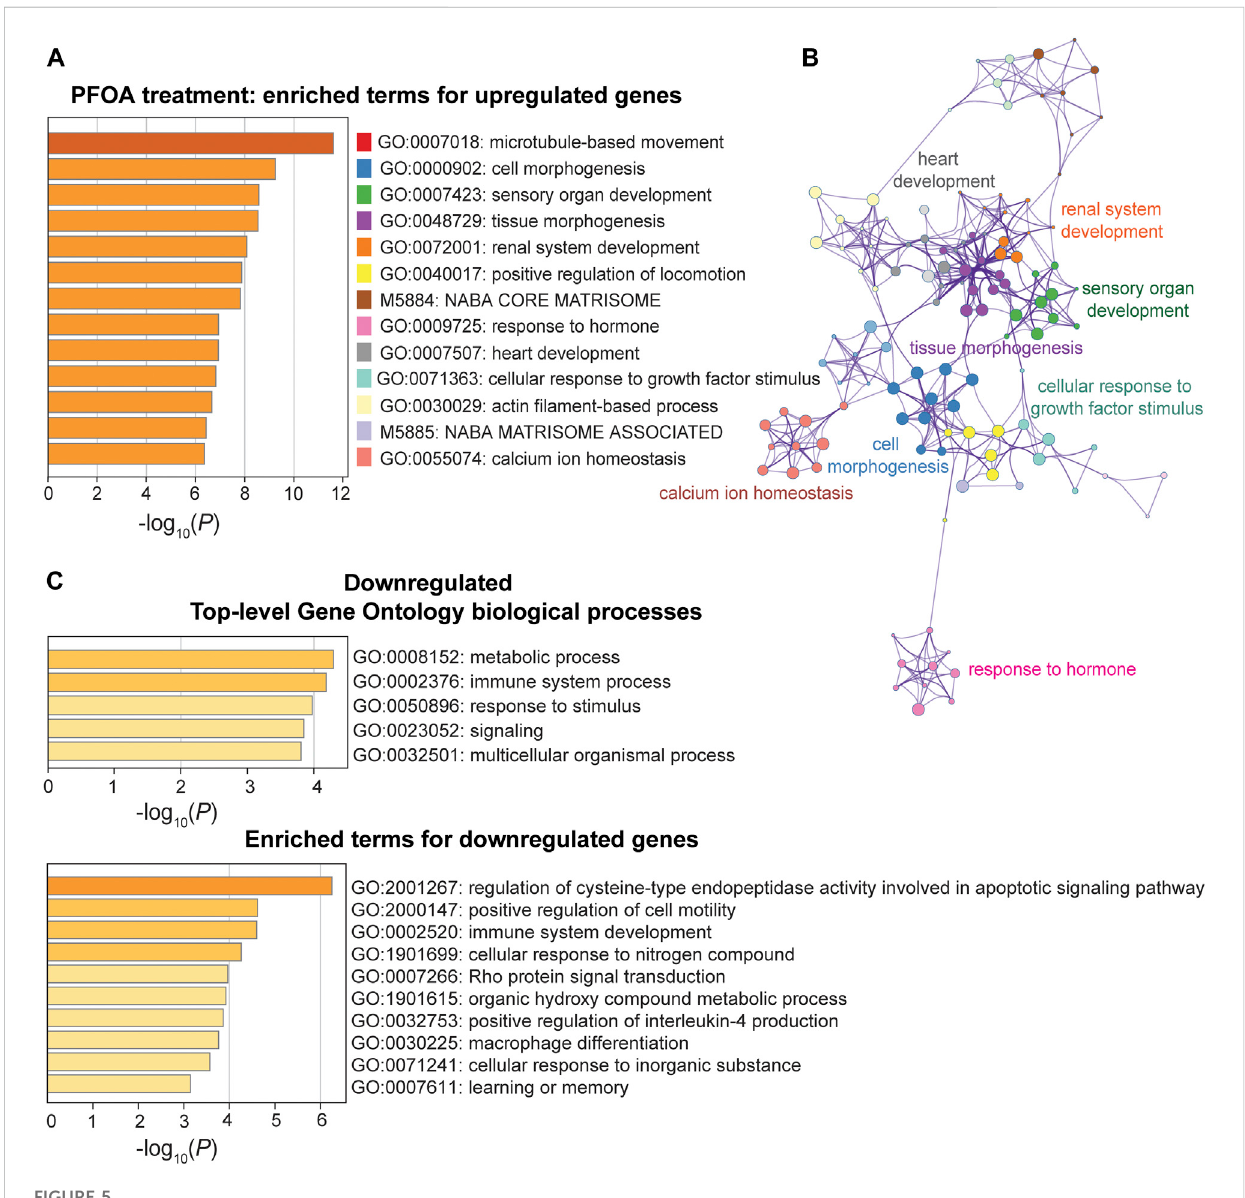
FIGURE 5 Pathway enrichment analysis of DEGs between the PFOA treatment and control groups. (A, C) Enriched functional categories for upregulated and downregulated genes in the PFOA treatment and control groups. Enrichment scores are measured by − log 10 ( p -value). (B) The network plot of enriched terms for upregulated genes. GO terms were represented by the same color dots as in (A)